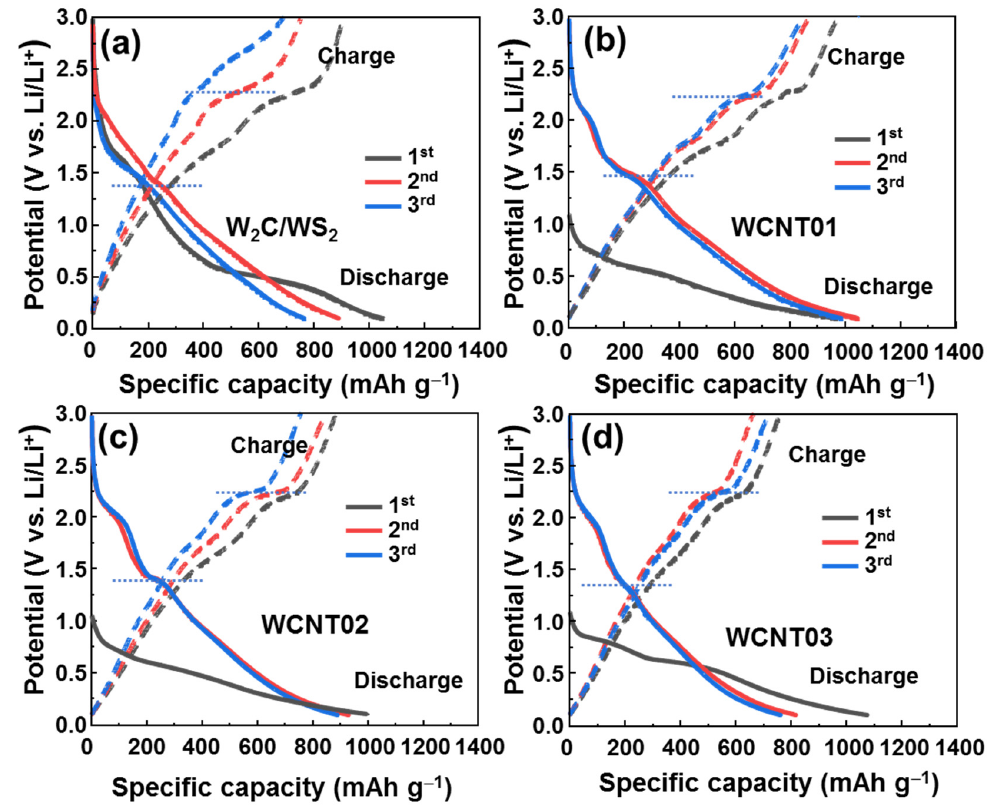
Figure 5. Initial voltage profiles of the ( a ) W 2 C / WS 2 alloys, ( b ) WCNT01, ( c ) WCNT02, and ( d ) WCNT03 anodes.